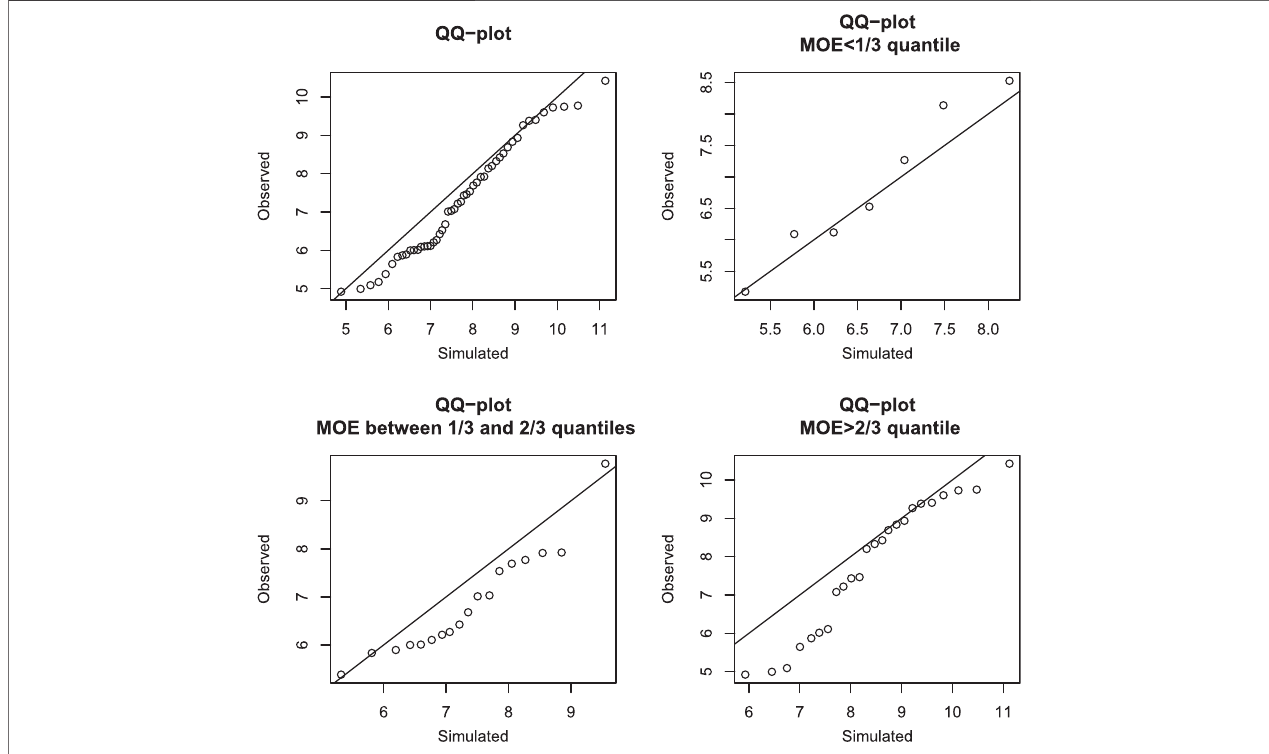
FIGURE 9 | Gaussian copula model and T40. Q-Q plot of observed residual MOR against simulated MOR with the identity line, given UTS greater than its 40 th quantile and MOE in different quantile intervals.